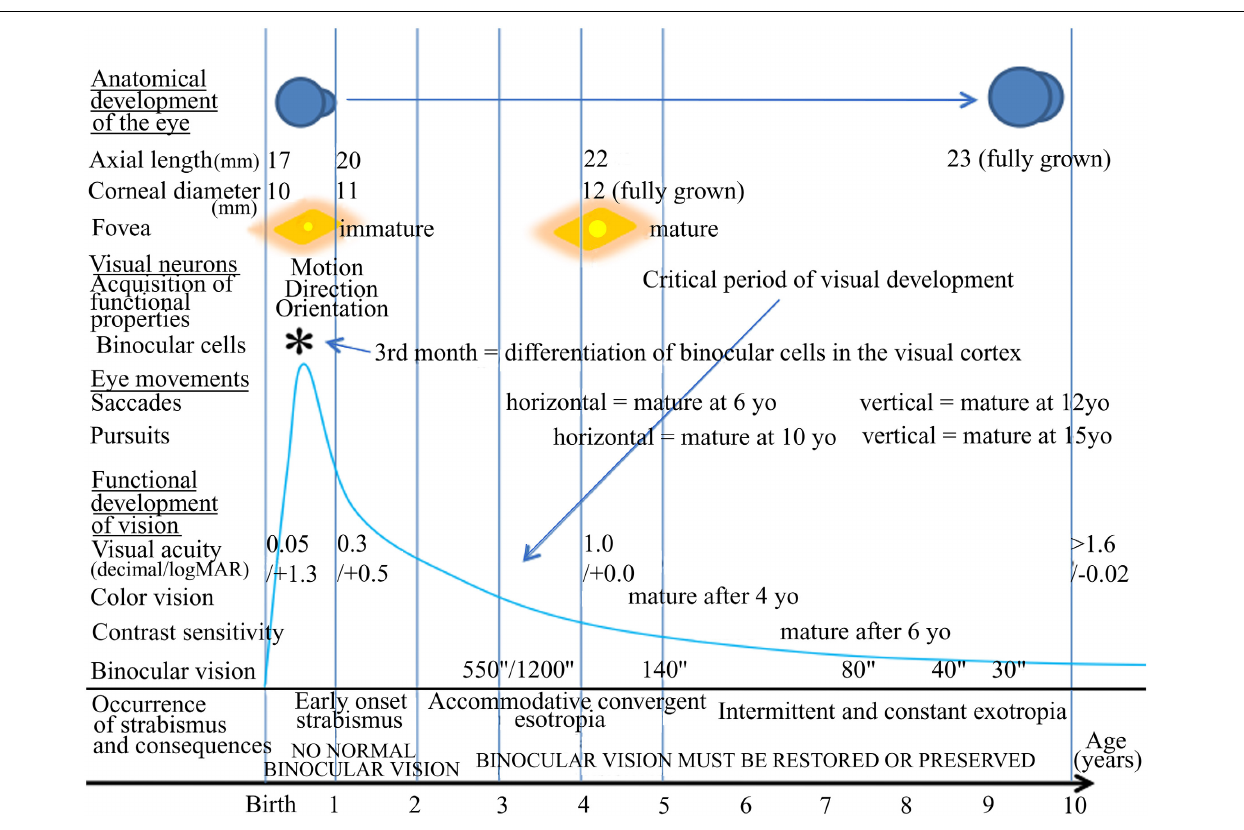
FIGURE 1 | Normal visual development in humans and times of occurrence of strabismus. The normal development of vision in humans is characterizedfirstbymorphologicalchangesincludingthegrowthoftheeye,an increase of the corneal diameter and the formation of numerous connections between the eyes and the cortex that organize progressively with age. In parallel,functionalchangesoccur.Theretinamatures,inparticularatthelevelof the fovea. Neurons in sub-cortical and cortical structures also progressively acquire adult functional characteristics. Among such latter processes, neurons in primary visual cortex (V1) progressively acquire the capacity to be activated by one given orientation, one given direction of movement, one given velocity of the stimulus and to be activated through one eye and the other, thus